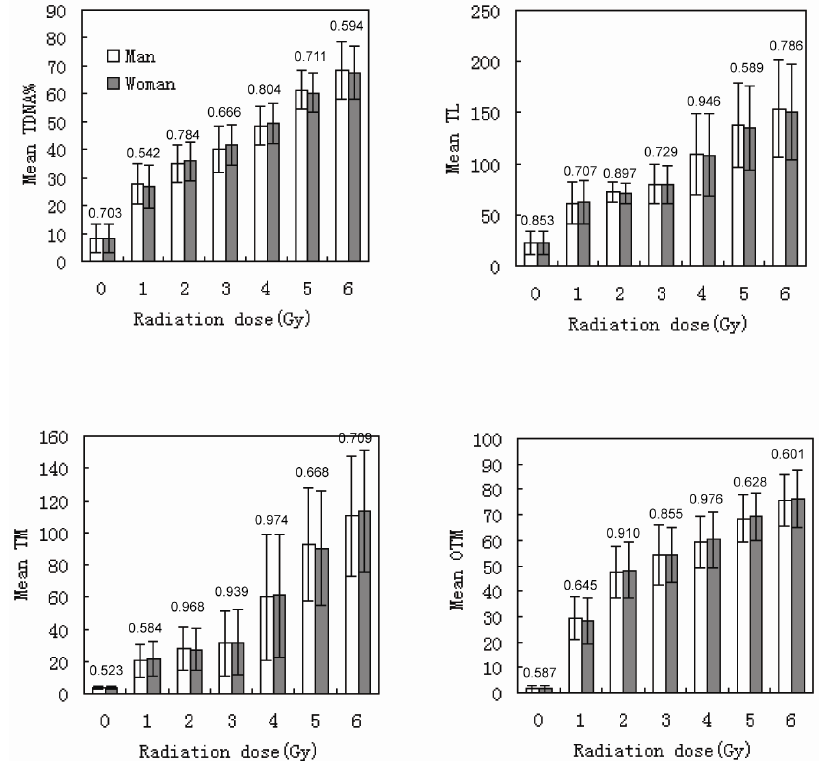
Figure 2. Variations in tail DNA (TDNA)%, tail length (TL), tail moment (TM), and olive tail moment (OTM) between male and female donors (the numbers above the column diagrams are p values between the male and female groups; error bars: ±1.00 SD).